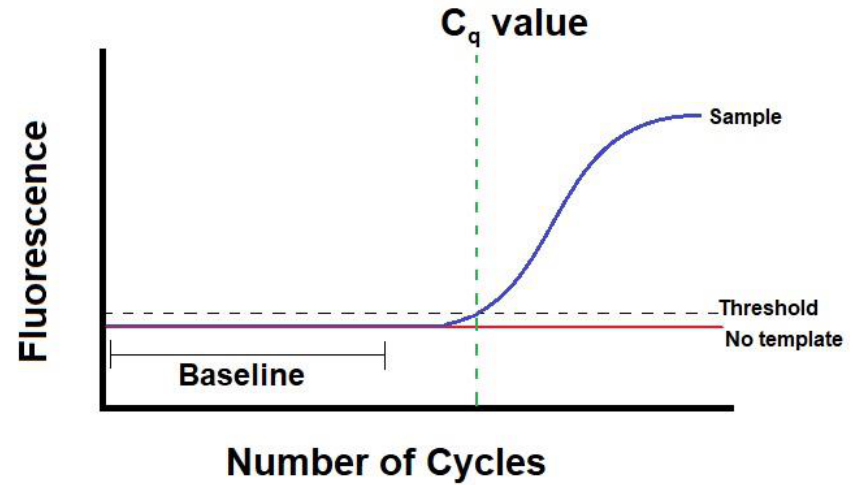
Figure 5. C q value on a quantitative real-time PCR amplification curve